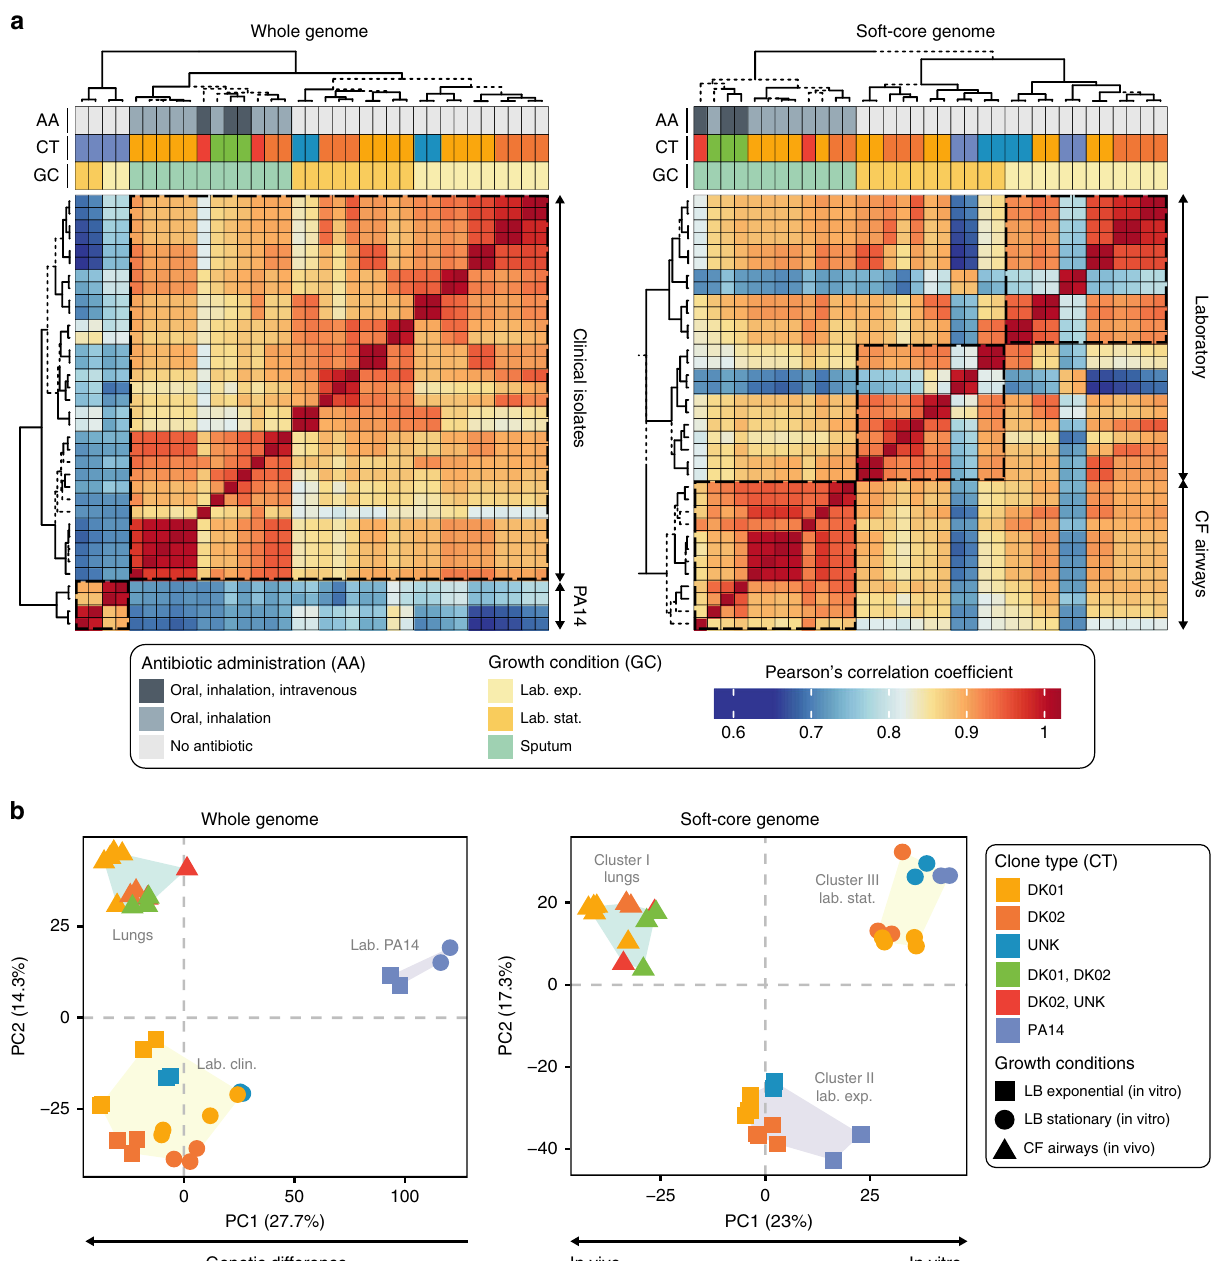
Fig. 2 Core genome analysis reduces genetic variability uncovering a shared transcriptional program. a Gene expression correlation expressed as Pearson ’ s correlation coef fi cient ( r ) and visualized as heat map of expression pro fi les deriving from the transcriptional activity of the whole genome (left panel, n = 5976 CDS) or soft-core genome (right panel, CDS conserved in 95% of the strains considered; n = 5102 CDS). Row and column clustering is based on results from pvclust analysis. Major signi fi cant clusters are highlighted by dashed rectangles, and solid lines in the side dendrograms. Dashed lines in dendrograms represent branches with AU values <95% and thus not considered signi fi cantly supported by data. b Cluster re fi nement by principal component analysis (PCA) and group identi fi cation based on k-means clustering on PCA data considering gene expression from the whole genome (left panel) or only coding sequences conserved in the soft-core genome of P. aeruginosa (right panel). Clusters identi fi ed by k-means analysis are labeled depending on major features of samples included in the group. For both analysis, rLog-normalized counts were used as representation of gene expression (see